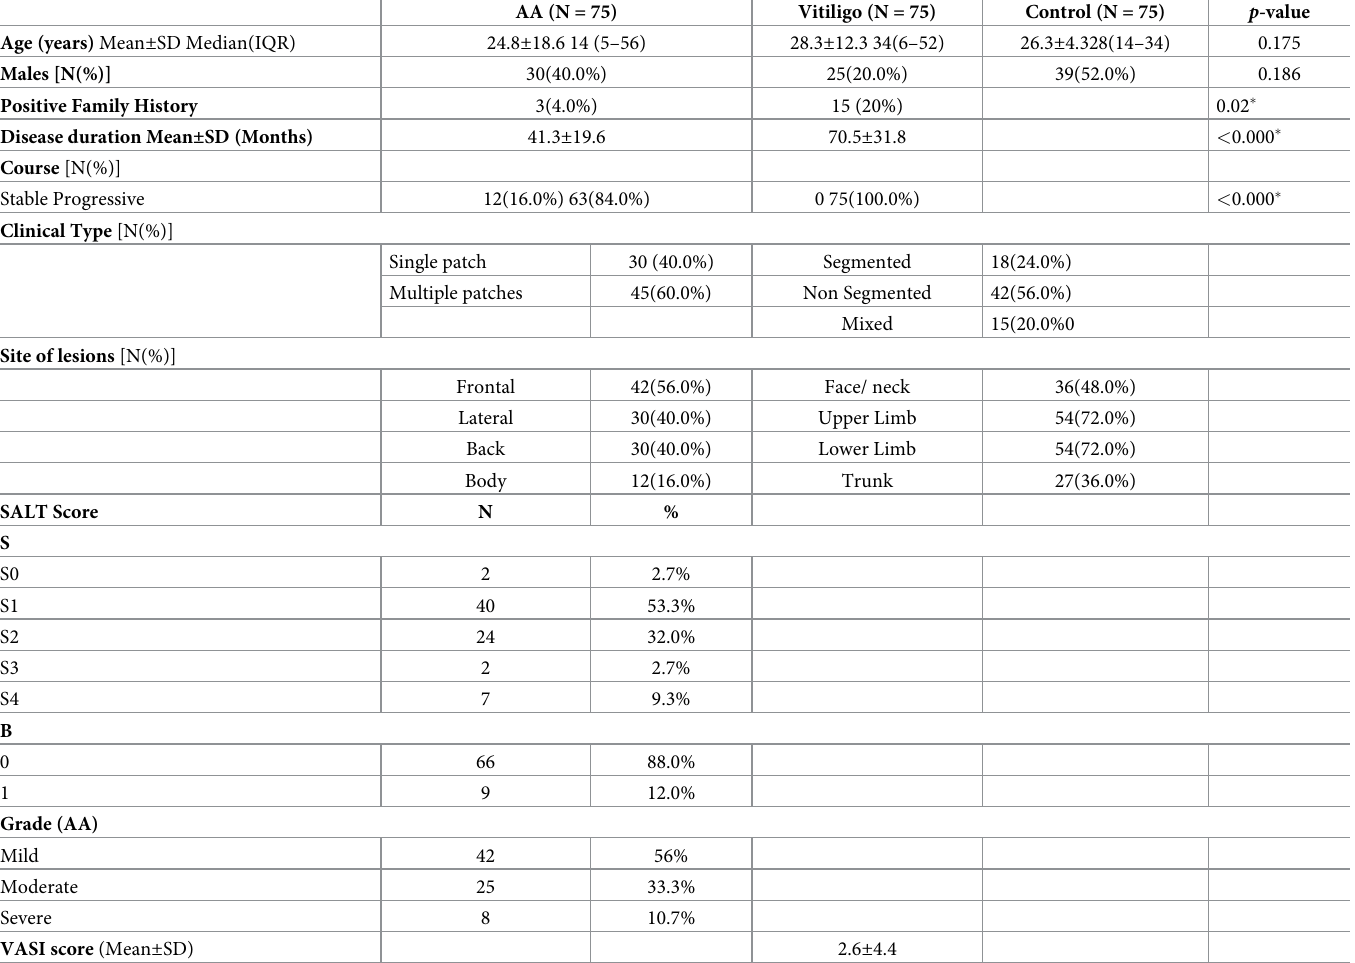
Table 1. Basic demographic and clinical characteristics of